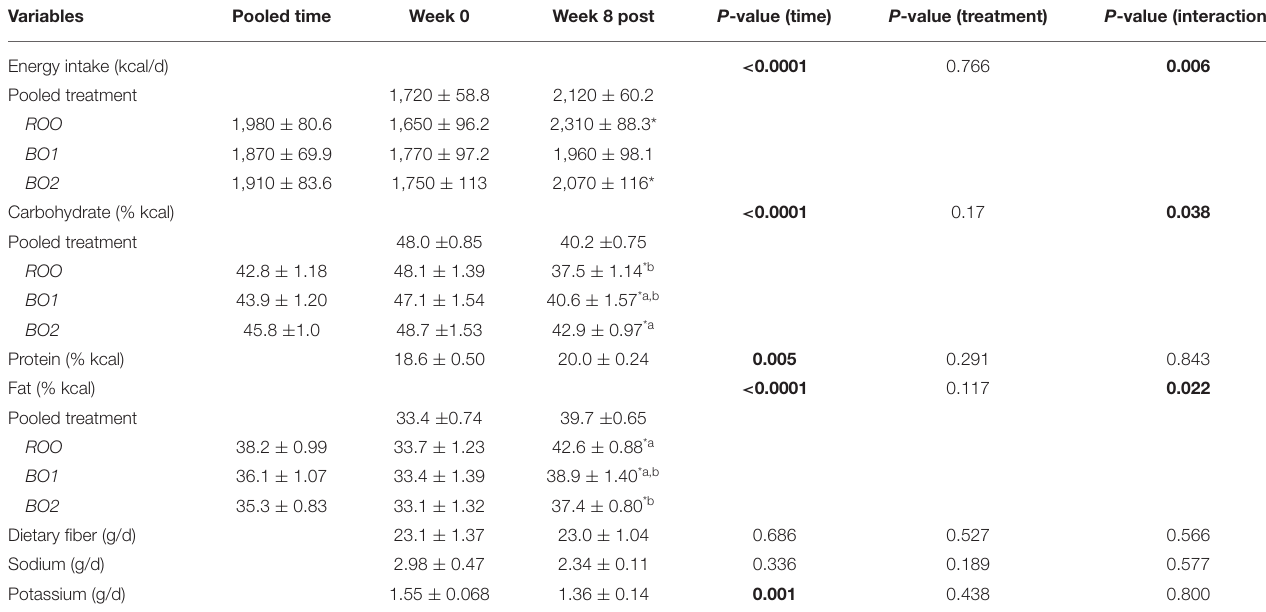
TABLE 2 | The nutrient data as mean ± standard error of the mean for the baseline and during intervention (week 8 post; which is the average of the post-baseline values) for each of the intervention groups in women, including only those who have completed the entire intervention ( N = 66; ROO = 24, BO1 = 20, BO2 = 22).